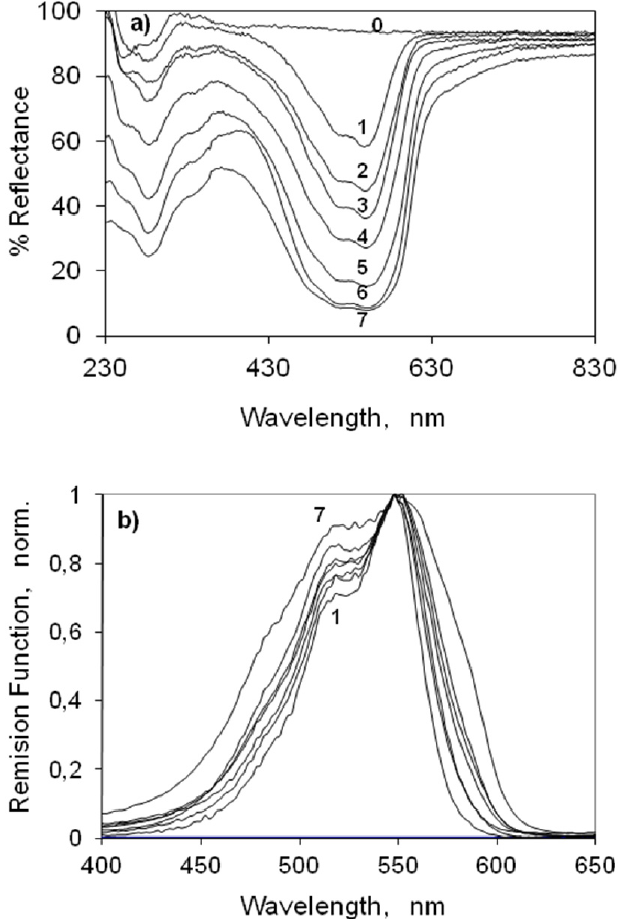
Figure 3. ( a ) Percentage Reflectance and ( b ) Remission function (normalized at the absorption maximum) of the 3,3'-di(2-sulfoethyl)-indocarbocyanine dye onto β -cyclodextrin. The molar ratios are (0) 0 (1) 1:1000 (2) 1:500 (3) 1:250 (4) 1:100 (5) 1:50 (6) 1:25 (7) 1:10 mol of the cyanine dye to moles of β